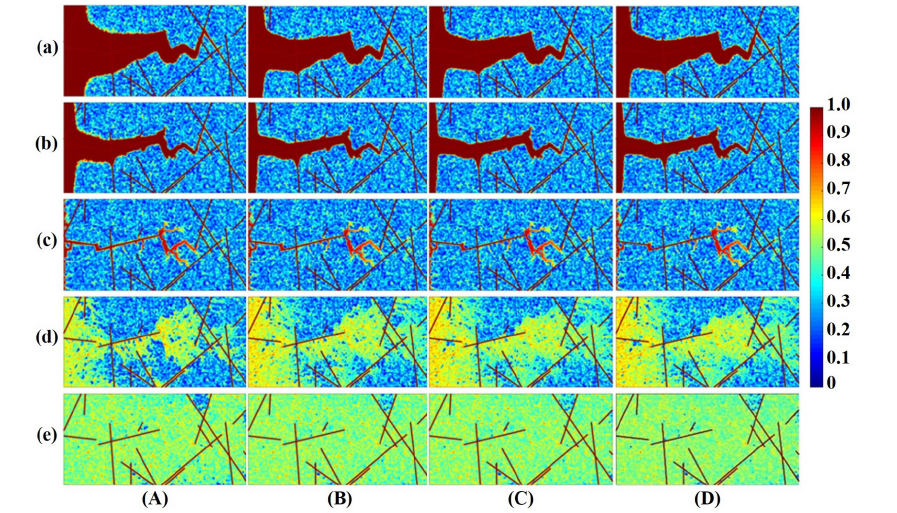
Figure 10. Comparison of dissolution structures at different effective stress: ( A ) σ = 0 MPa, ( B ) σ = 15 MPa, ( C ) σ = 30 MPa, ( D ) σ = 45 MPa and at different injection rates: 1/ Da =